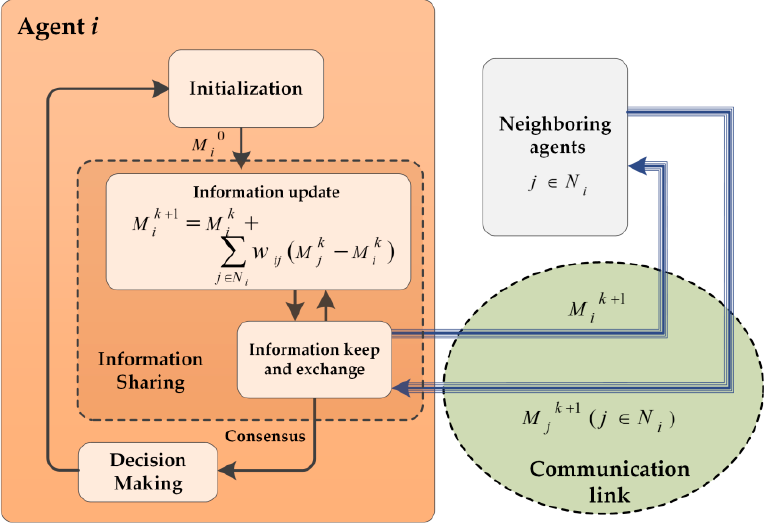
Figure 8. Function of agent i for MG restoration.